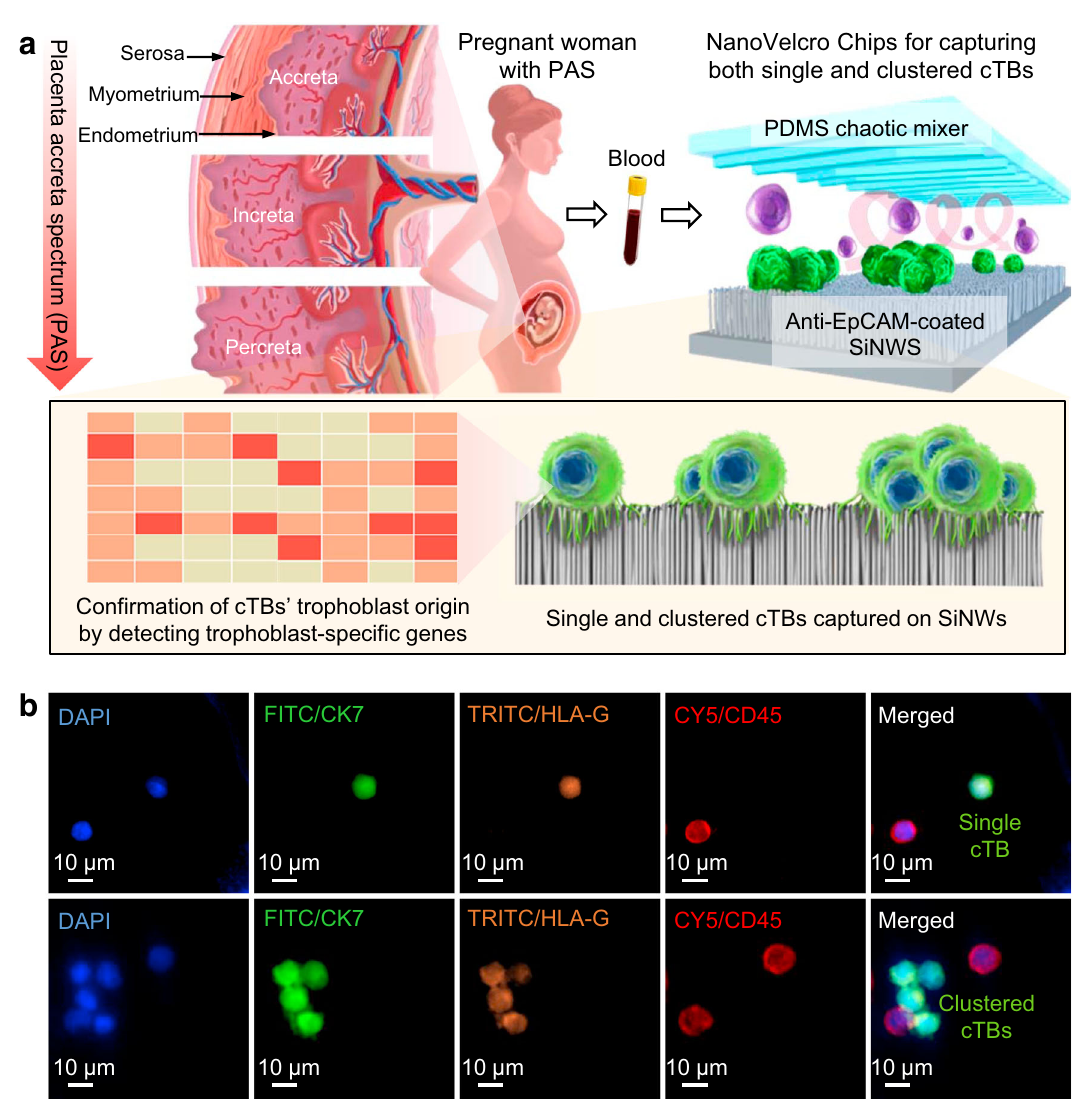
Fig. 1 NanoVelcro Chips for detecting single and clustered circulating trophoblasts (cTBs) in placenta accreta spectrum (PAS) disorder. a Abnormal invasion and adherence of placental trophoblasts into the uterine myometrium, classi fi ed into placenta accreta, increta, and percreta based on the severity of the disorder. During implantation and placentation, a small number of cTBs sheds from the placenta into the maternal circulation. NanoVelcro Chip, composed of an overlaid polydimethylsiloxane (PDMS) chaotic mixer and an anti-EpCAM-coated silicon nanowire substrates (SiNWS), was adopted to capture both single and clustered cTBs (colored in green) in maternal blood, allowing for noninvasive detection of PAS disorder. The trophoblast origin of the cTBs was con fi rmed by detecting trophoblast-speci fi c genes and immunocytochemistry (ICC) staining on the captured cTBs. b Representative micrographs of ICC staining on a single cTB and clustered cTBs (DAPI + /CK7 + /HLA-G + /CD45 – ) captured by NanoVelcro Chips. Blue: DAPI stained nuclei; green: FITC stained CK7; orange: TRITC stained HLA-G; red: CY5 stained CD45. Scale bar, 10 µ m. Data are representatives of fi ve independent